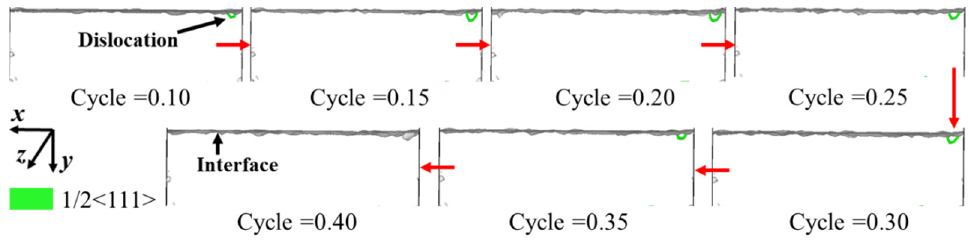
Figure 10. Nucleation and annihilation process of a 1/2<111> dislocation on the interface when γ 2 is applied along the y -axis. The whole process is contained in the first cycle.